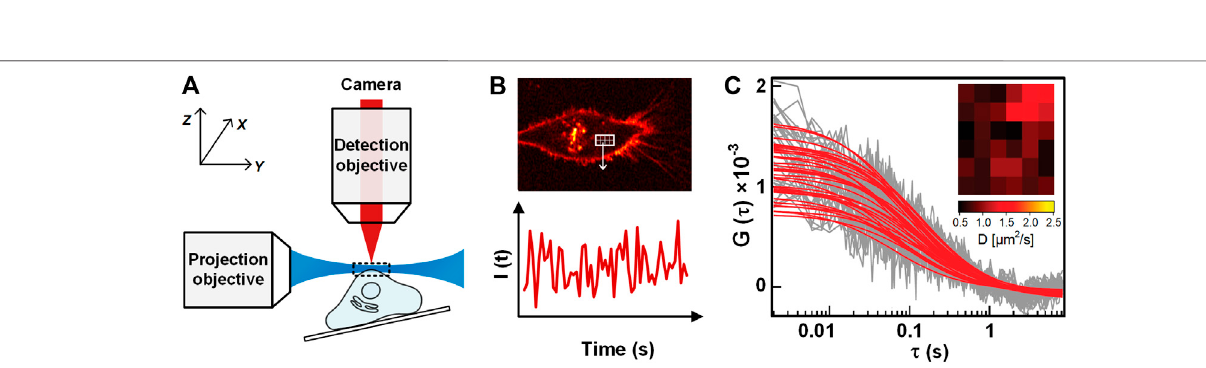
FIGURE 7 | TIR-FCS and nano-channel based FCS. Con fi gurations of total internal re fl ection (TIRF) based FCS ( A ) and nano-channel based FCS ( B ).